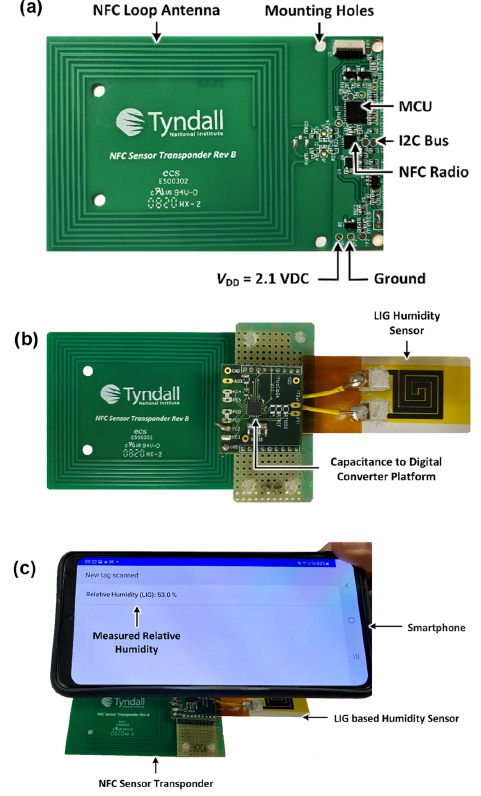
Figure 7. NFC sensor integration. ( a ) NFC transponder with loop antenna for wireless powering; ( b ) battery-less NFC-enabled humidity sensor; ( c ) demonstration of the NFC-enabled humidity sensor; wirelessly powered using a smartphone.